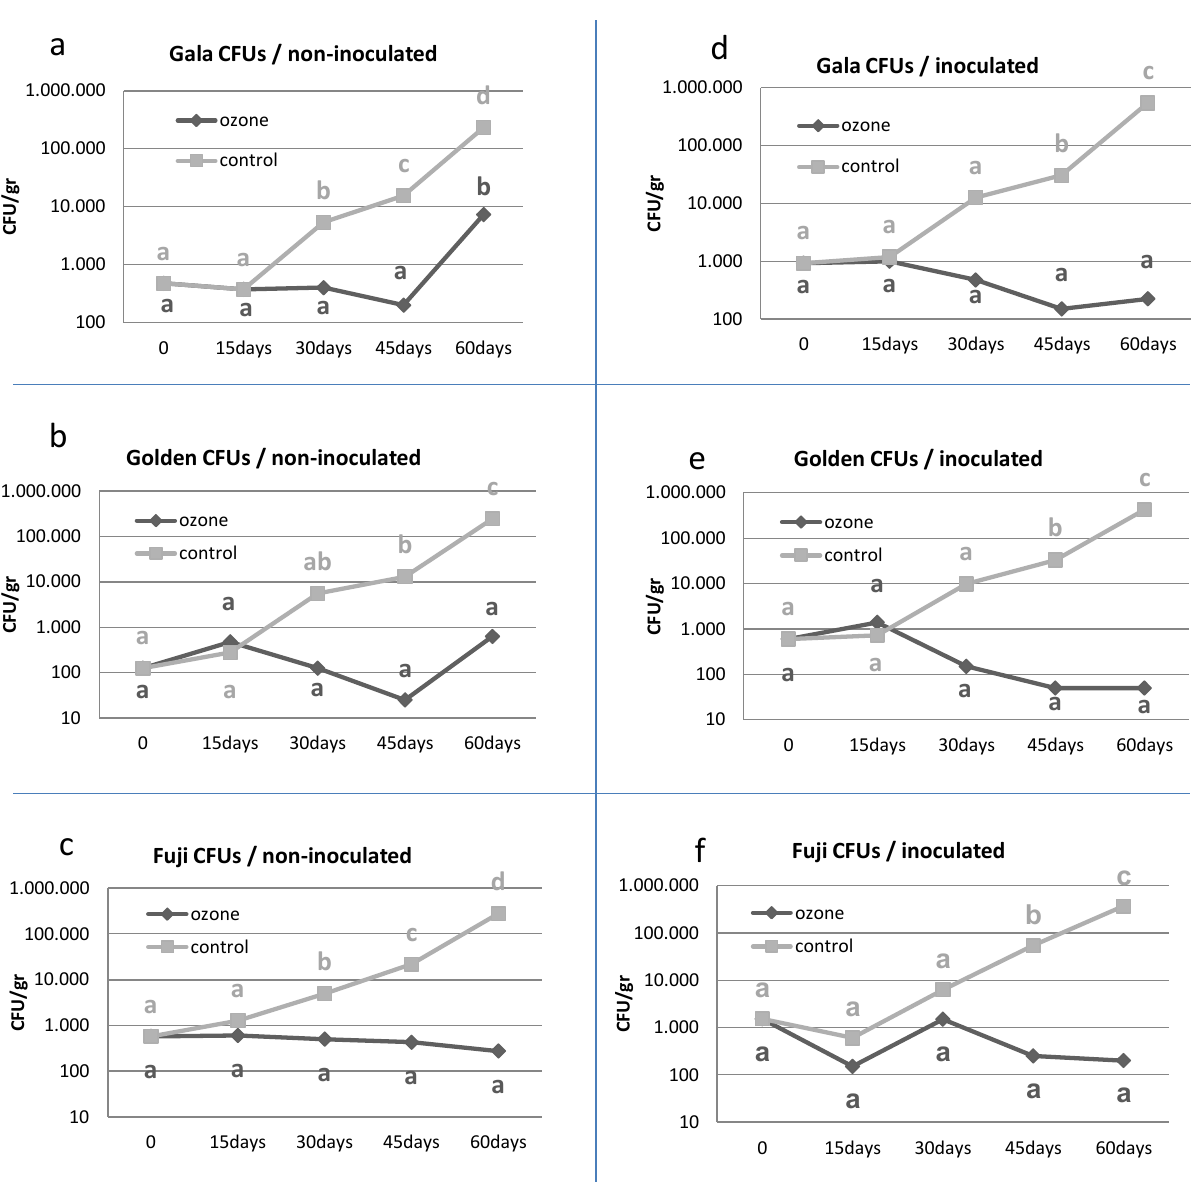
Figure 1. Penicillium expansum colony forming units (CFUs) from the surface of non-inoculated (a, b, c) and P. expansum -in- oculated (d, e, f) apple fruit (‘Royal Gala’, ‘Golden Delicious’ and ‘Fuji’), either non-treated (control) or treated with ozone (0.5 μL L -1 ) and stored at 1 ± 1°C in the dark. Means followed by the same letter are not significantly different (Fisher’s Least Significance Difference test (LSD, P =